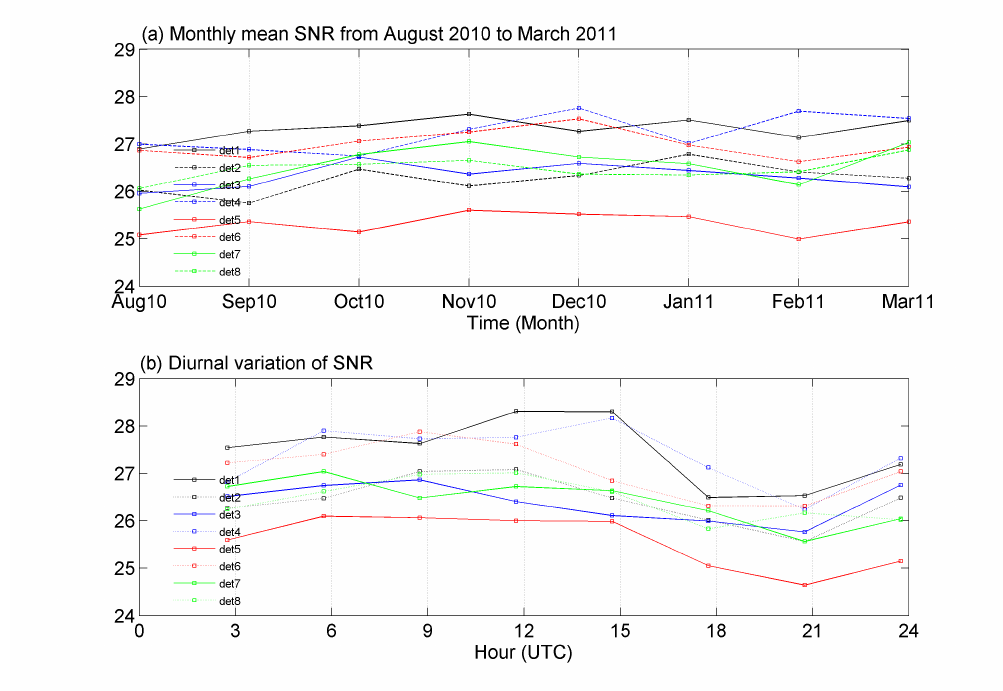
Figure 5. Time series of SNR of visible channels. (a) Monthly mean SNR of eight detectors from August 2010 to March 2011. (b) Diurnal variation of SNR for full-disk images (every 3h interval of measurement schedule for COMS/MI).